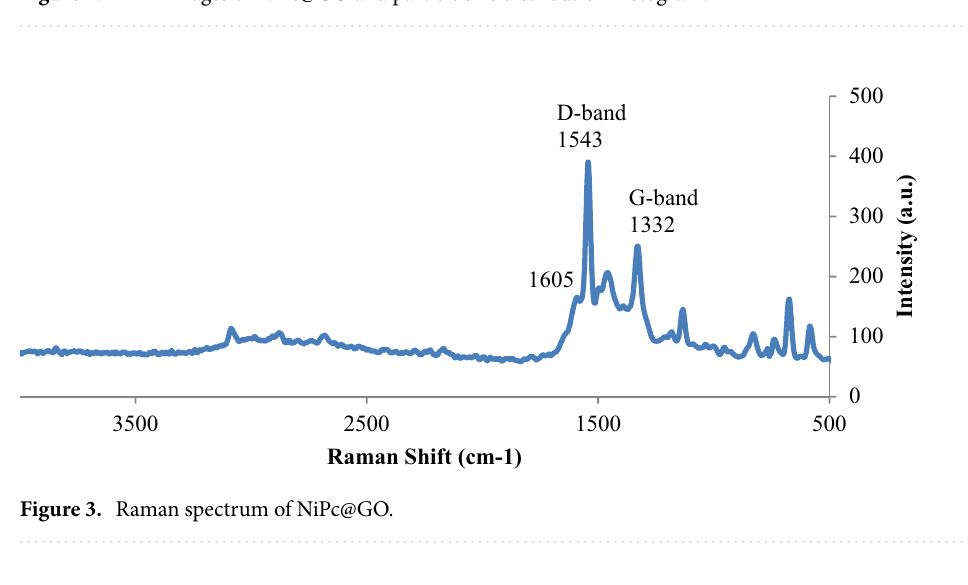
Figure 2. TEM images of NiPc@GO and particle size distribution histogram.